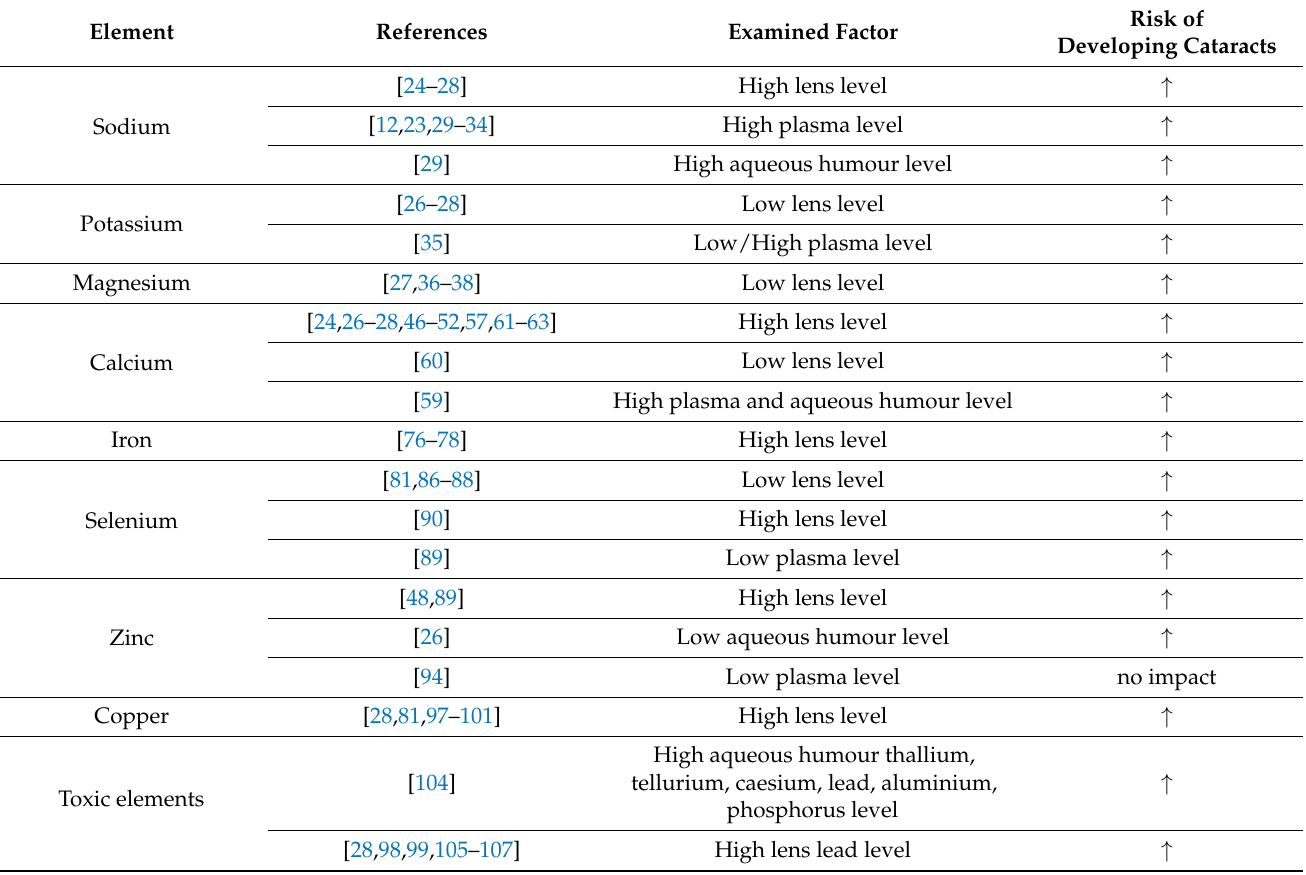
Table 2. Levels of selected micro and macroelement and associated risk of developing cataracts.